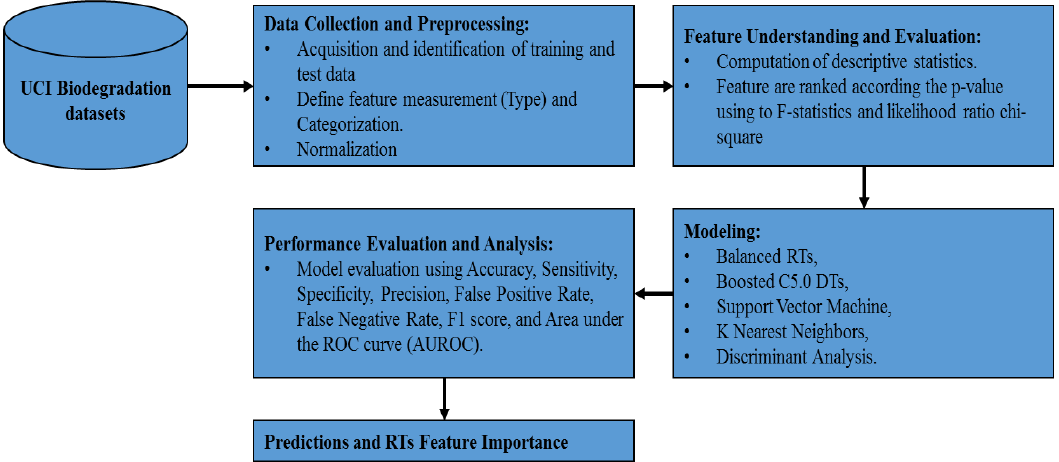
Figure 1. The proposed methodology based on the Extract, Load, Transform and Analyze (ELTA) approach [21].